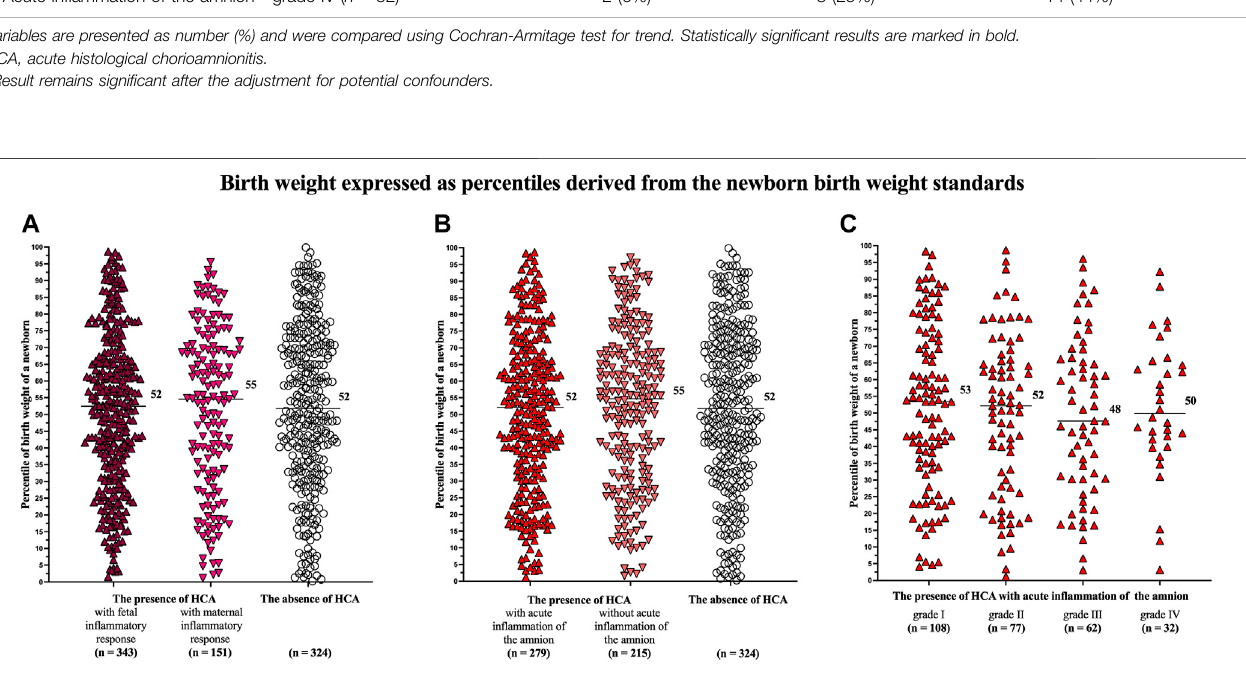
FIGURE 2| Comparison of the birthweights of newborns, expressed as percentiles derived from the newborn birth weight standards, among the women with the presenceofHCAwithfetalandmaternalin fl ammatoryresponsesandthosewiththeabsenceofHCA (A) ;amongthewomenwiththepresenceofHCAwithand without acute in fl ammation of the amnion and those with the absence of HCA (B) ; and among the women with acute in fl ammation of the amnion divided based on its severity (grades I-IV) (C) . No difference was observed among the women with the presence of HCA with fetal and maternal in fl ammatory responses and those with